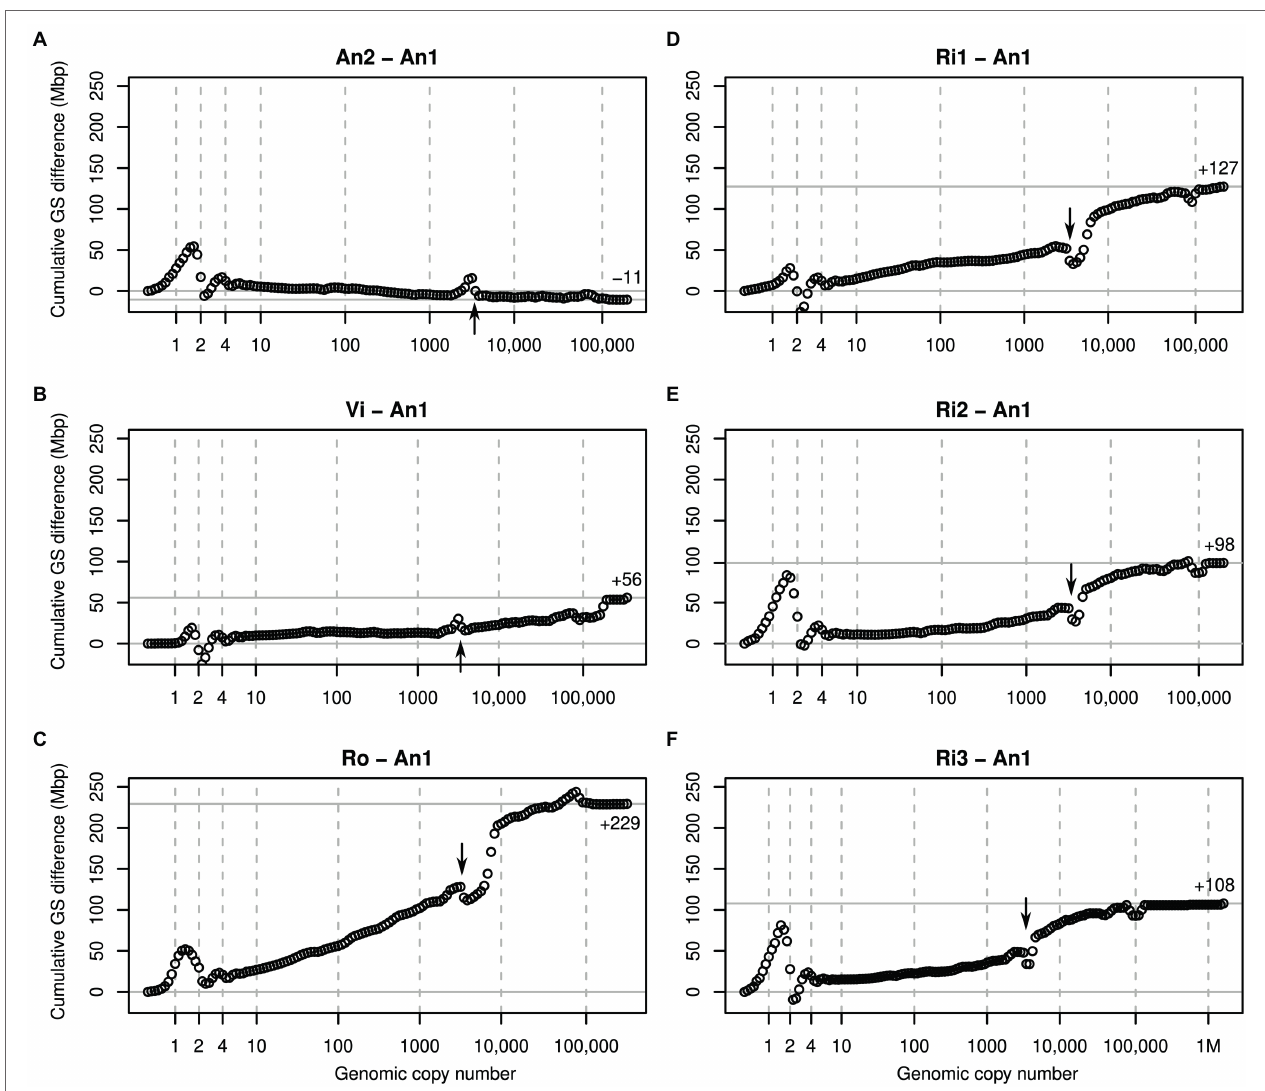
FIGURE 3 | Cumulative k-mer difference graphs detailing the contributions to genome size differences of genome fractions ordered by increasing repetitiveness for six samples of diploid Euphrasia compared to diploid Euphrasia anglica (An1). The numbers on the x-axes indicate the genomic copy number bins with 1, 2 and 4 representing haploid, diploid, and ‘duplicated’ sequences. The genome size differences are shown on the y-axes, scaled identically for all graphs. The total genome size difference between the two samples in each graph is indicated at the right-hand side of each plot and by a horizontal grey line. The arrows indicate a ‘gap’ caused by copy number variation of a repeat present in approximately 3,000 copies in the reference individual. The panels show comparisons six different individuals to the reference: (A) E. anglica , (B) E. vigursii , (C) E. rostkoviana , (D-F) E. rivularis